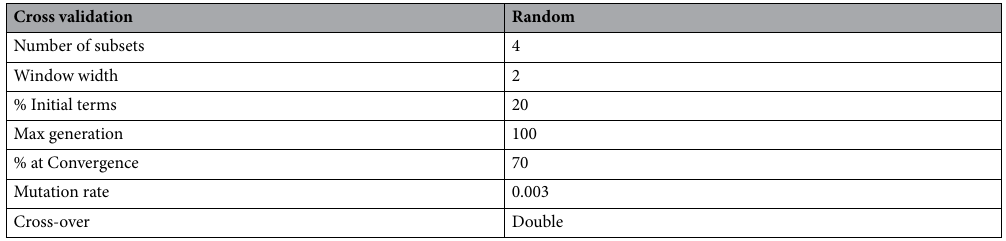
Table 2. Parameters of the genetic